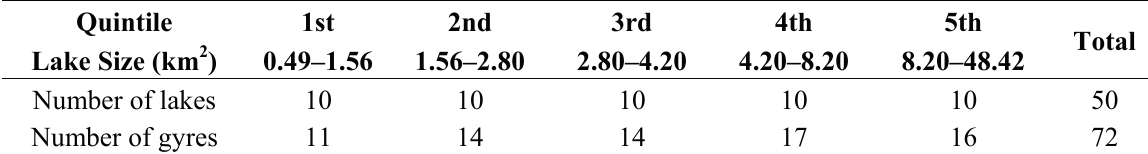
Table 5. Number of gyres found in lakes of difference sizes on 10 July